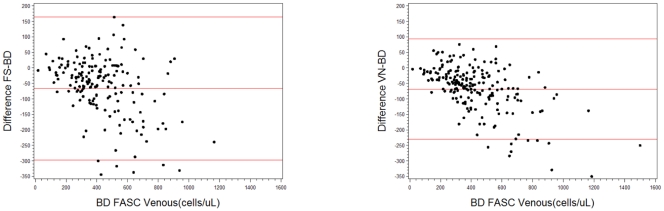
Bland Altman analyses of Pima test results compared to BD FASCalibur method.a) Pima capillary samples and, b) Pima venous samples, versus the BD FACS reference method. Upper and lower lines show 2 standard deviations from the mean (center line).